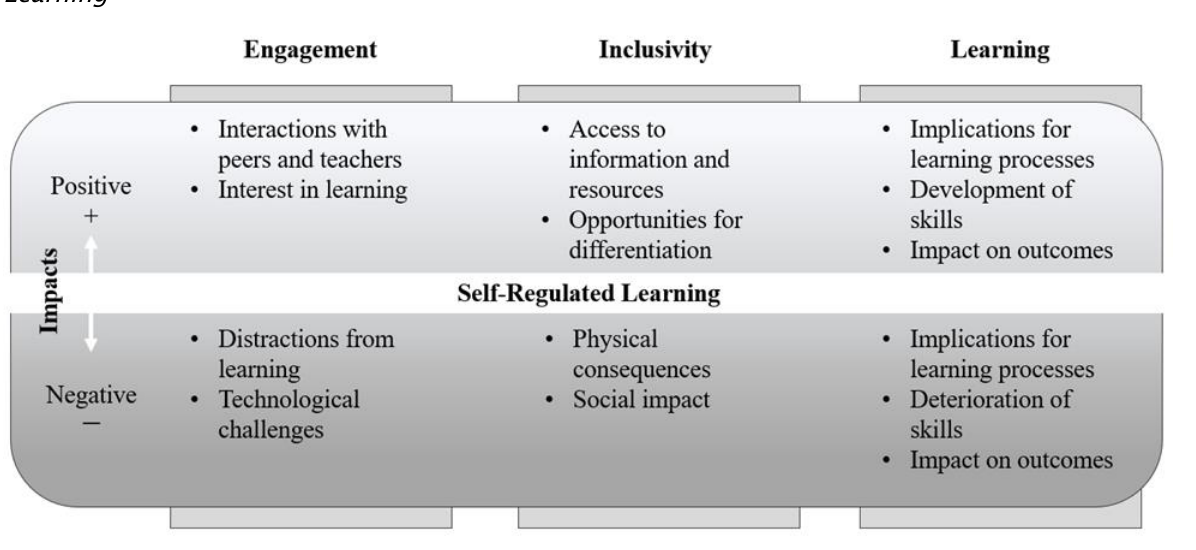
Figure 2 represents the impacts of 1:1 devices as a positive-negative continuum, whereby the negative impacts can be moderated through self-regulated learning. Students who develop self-regulation skills are better able to monitor and continually modify their technology use to achieve their learning goals (Liou & Kuo, 2014; Sandars, 2013) and likely become less susceptible to potential undesired impacts of technology for learning. They are also better able to self-assess after a learning task (Sandars, 2013) to determine how technology might have helped or hindered their performance.